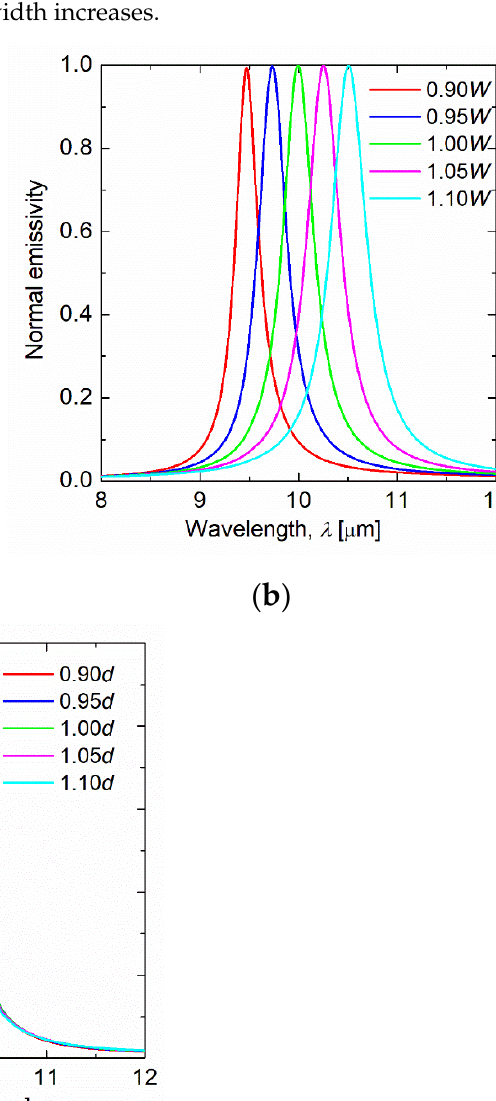
Figure 7. ( a ) Normal emissivity spectrum for graphene ribbon metasurface with different electron mobilities of graphene. The target wavelength is 10 µm, and the electron mobilities of graphene are µ = 0.10, 0.20, 0.60, 2.0, and 6.0 m 2 /Vs. ( b ) Quality factor for different mobilities of graphene, and bandwidth parameter β . Normal emissivity is calculated from RLC circuit model to obtain the quality factor.